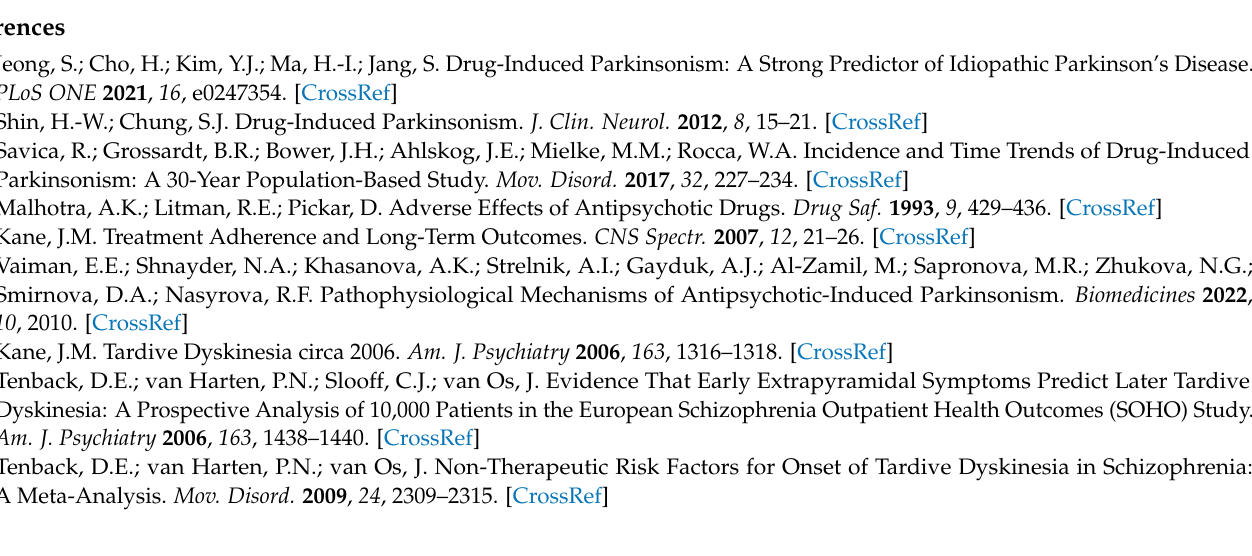
Table S3: ESRS-based AIP scores in haloperidol-treated schizophrenia patients with different HTR2C rs3813929-rs518147 haplotypes; Table S4: ESRS-based AIP scores in haloperidol-treated schizophrenia patients with different HTR6 rs1805054 genotypes; Table S5: ESRS-based AIP scores in